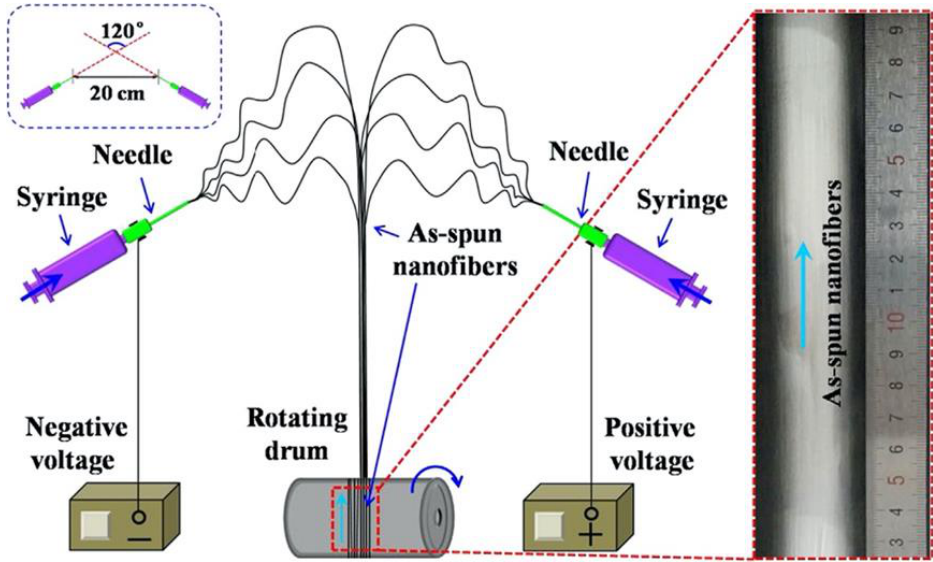
Figure 3. Schematic diagram of conjugate electrospinning (Reprinted with permission from Ref. [22]. 2017 Elsevier).